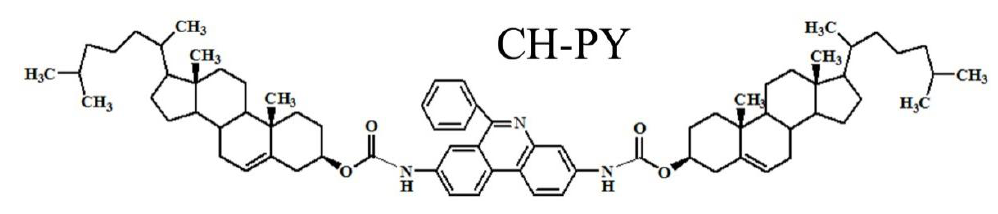
Figure 7. Structure and abbreviation of bolaform cholesteryl imide derivative with aromatic